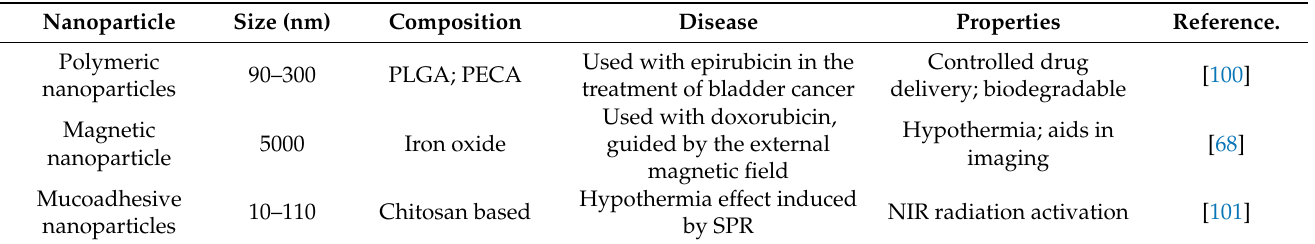
Table 3. Characteristics, particle size, composition and applications of different types of nanoparticles currently employed in